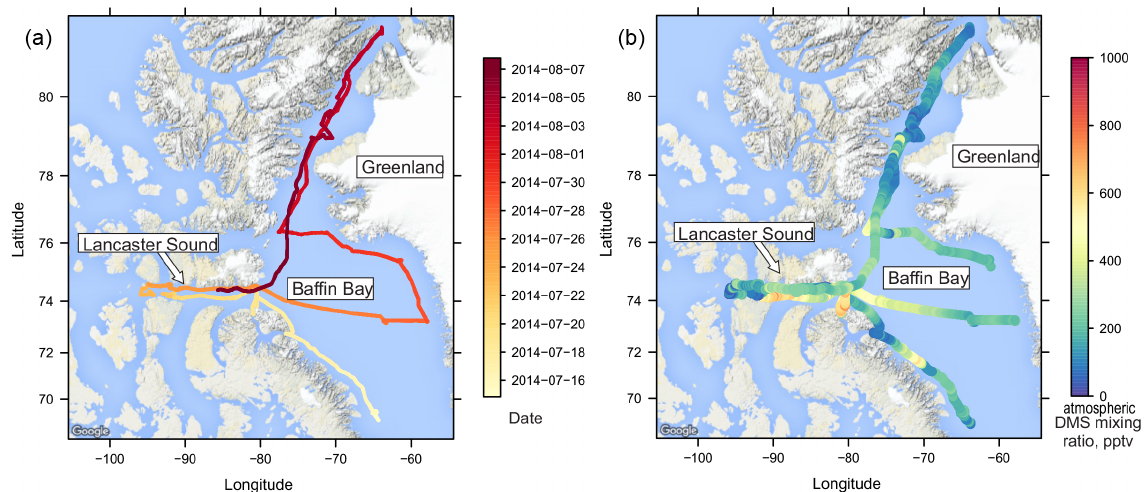
Figure 1. (a) The Amundsen ship position with dates indicated by colours. (b) Surface-layer atmospheric dimethyl sulfide (DMS) mix- ing ratios from ship-based high-resolution time-of-flight chemical ionization mass spectrometer (HR-ToF-CIMS) measurement with colour showing magnitude of mixing